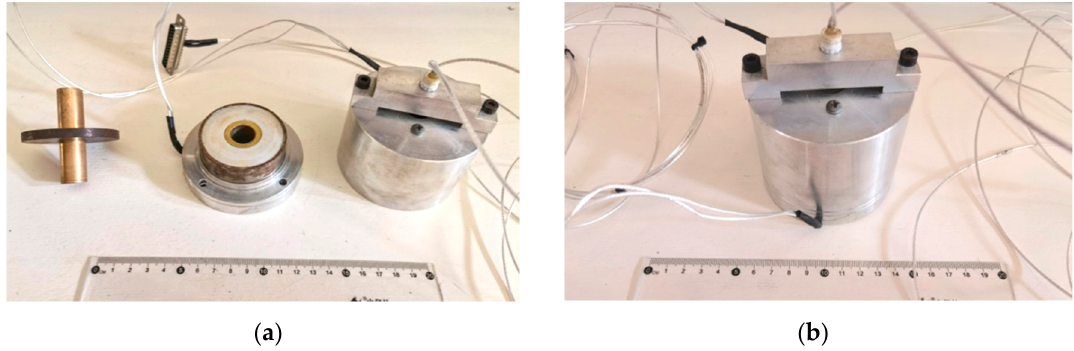
Figure 13. Test device diagram. ( a ) Parts; ( b ) assembled device.